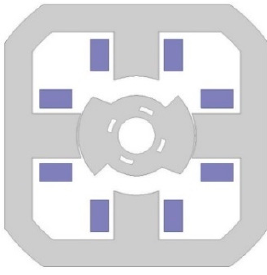
Figure 1. Structure of the proposed two ‐ phase 4/2 pole SRM.